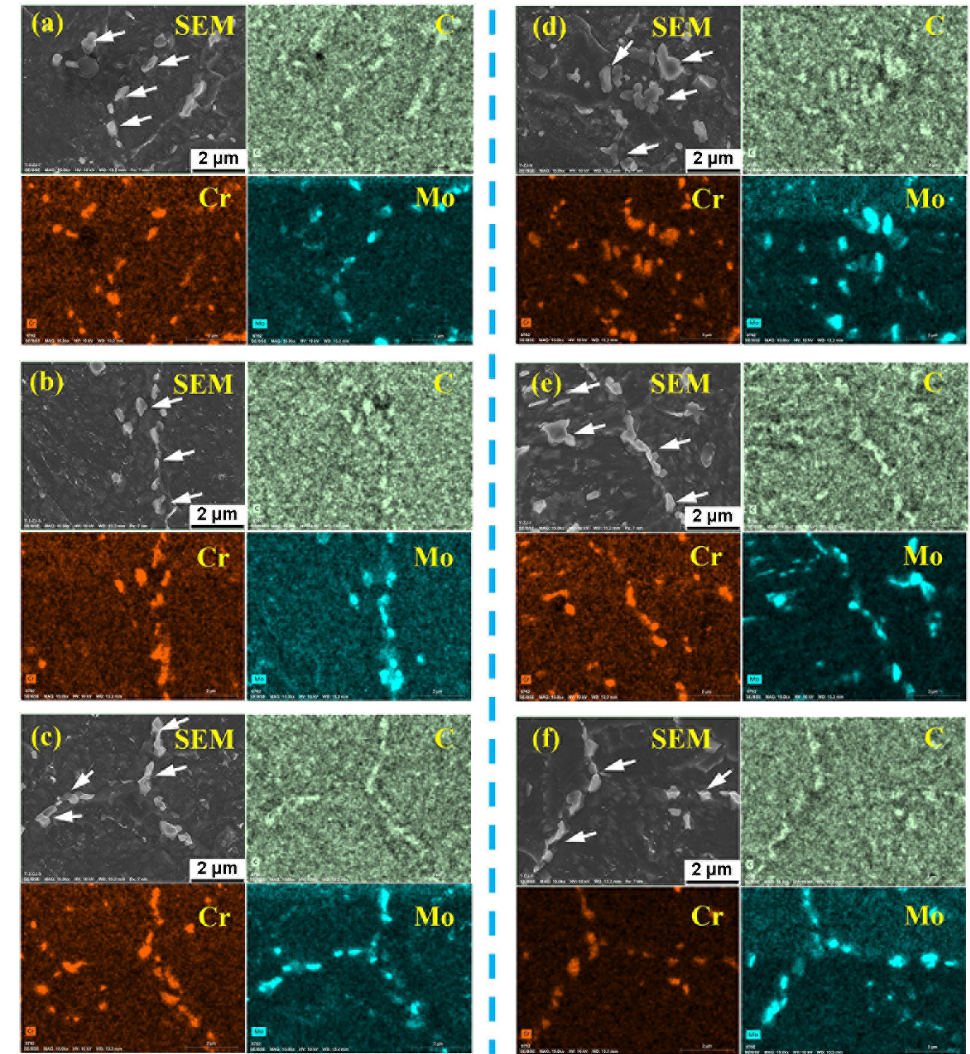
Figure 6. Carbides in the WMs: ( a – c ) the turbine part; ( d – f ) the compressor part; ( a , d ) the upper part of the columnar zone; ( b , e ) the lower part of the columnar zone; ( c , f ) the interlayer zone. The white arrows point to carbides.